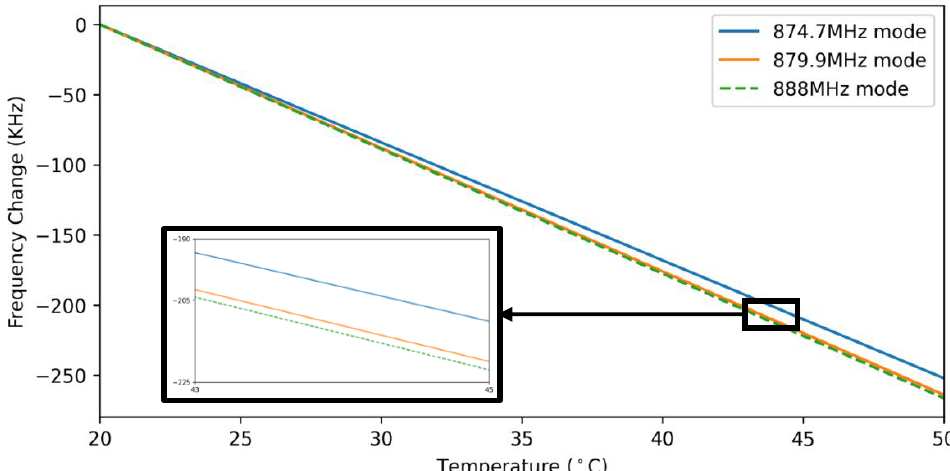
Figure 4. Simulated temperature-frequency profile of 874.7 and 879.9 MHz modes of thin-film piezoelectric-on-substrate (TPoS) MEMS resonator used in the sensor. This resonator is fabricated on a 3 µm nanocrystalline diamond-on-silicon substrate covered by 500 nm of sputtered AlN. The frequency change profile of the 879.9 and 888 MHz modes is very similar because of their common operating mode, and the small variation can be attributed to the difference in center frequency.